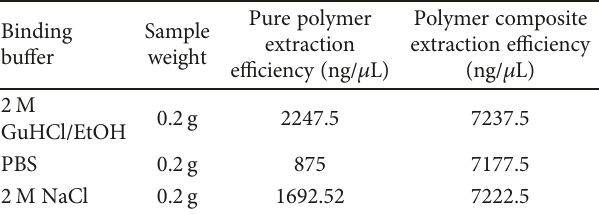
Table 4: Comparison of the extraction e ffi ciencies of pure polymer, poly(4,4 ′ -cyclohexylidene bisphenol oxalate) with that of poly(4,4 ′ -cyclohexylidene bisphenol oxalate)-MCC-magnetite